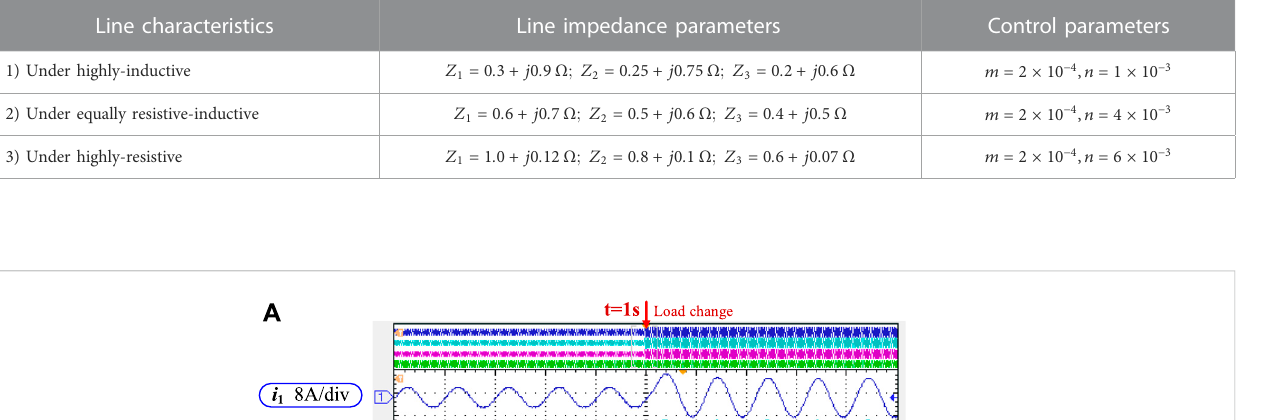
TABLE 5 Physical line parameters and control parameters of the experiment. Line characteristics